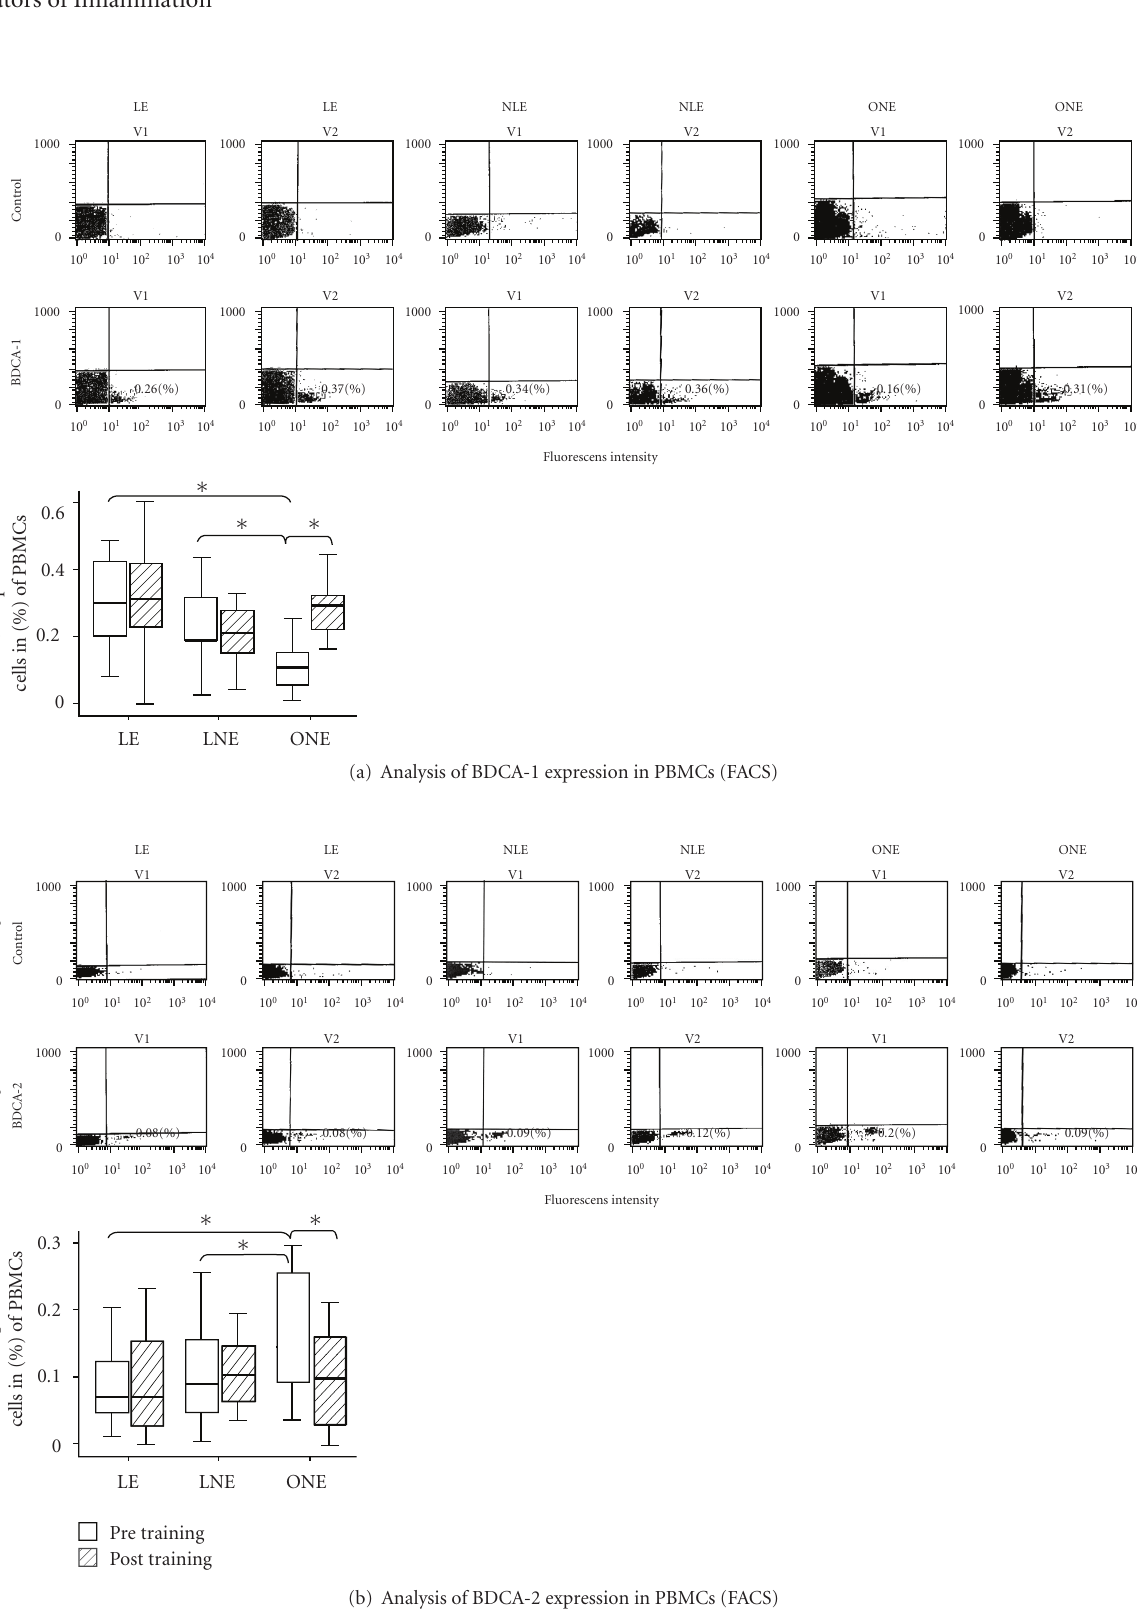
Figure 1: Representative FACS scans in PBMC expressing of BDCA-1 (a) and BDCA-2 (b) in LE, LNE, and ONE at baseline and after training. Data presented state the expression of the corresponding receptors in percent. Statistical analysis of the di ff erent timepoints (intra group analysis) was performed using the Wilcoxon Test; the comparison of the di ff erent groups with each other (inter group analysis) was done by using the Mann-Whitney U Test ( ∗ P < . 05; n = 15 / 16 /